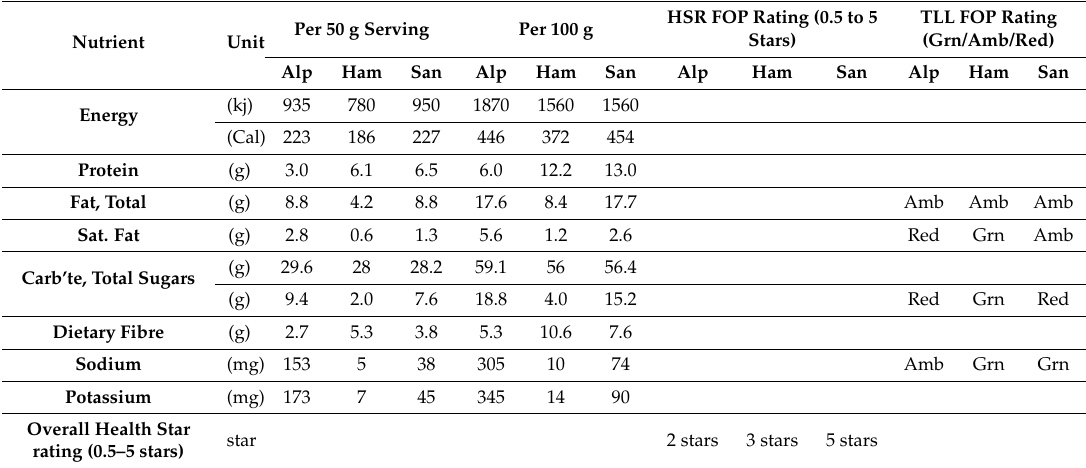
Table 1. Nutritional status of the three products used via nutrition information panel (NIP), and related HSR and traffic light label (TLL) front of pack FOP ratings.